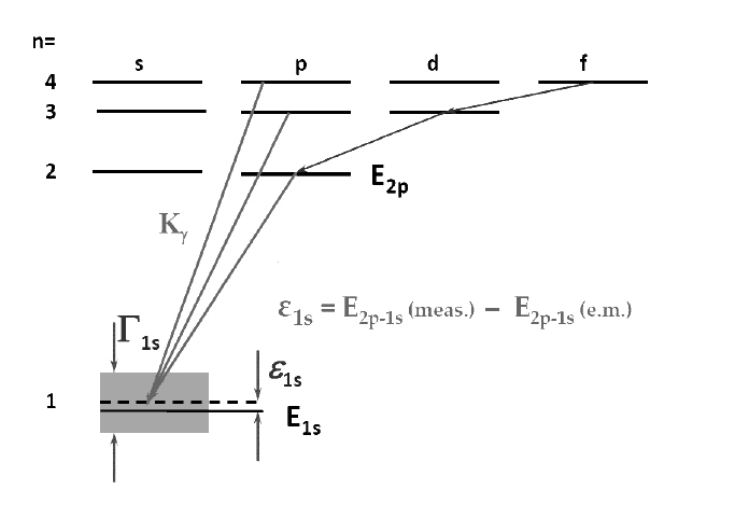
Figure 1. Transitions to the 1s ground state in kaonic hydrogen. Only the 1s state is measurably influenced by the strong antikaon-nucleon interaction. The calculated electromagnetic transition energy is about 6.5 keV which can be precisely measured with